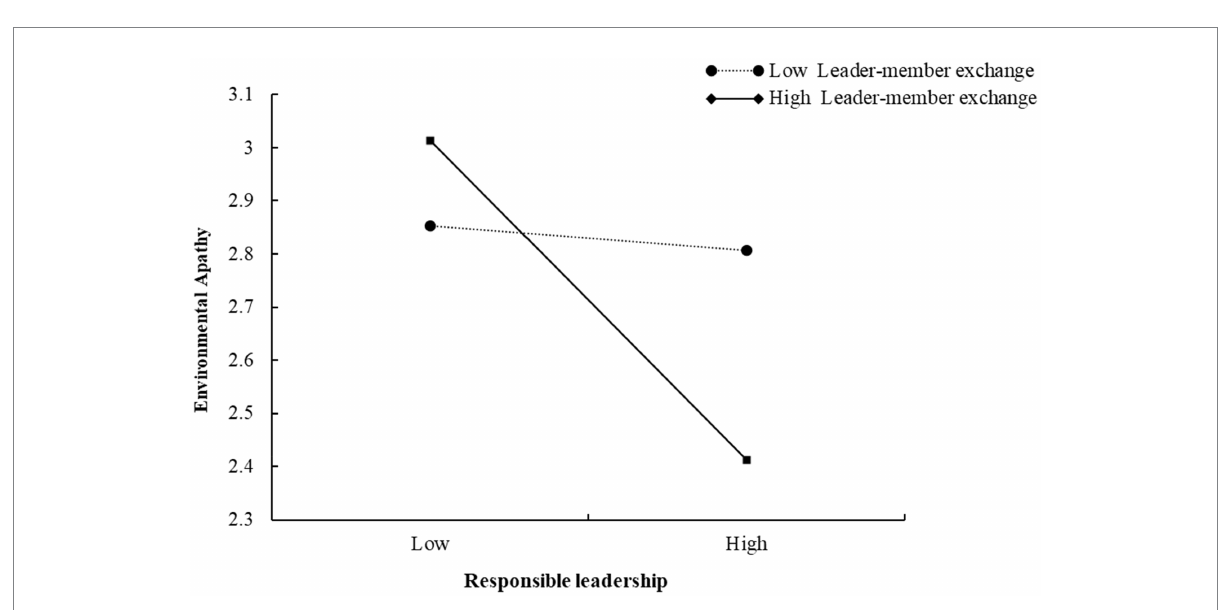
FIGURE 3 The moderating effect of LMX on the relationship between responsible leadership and employees’ environmental